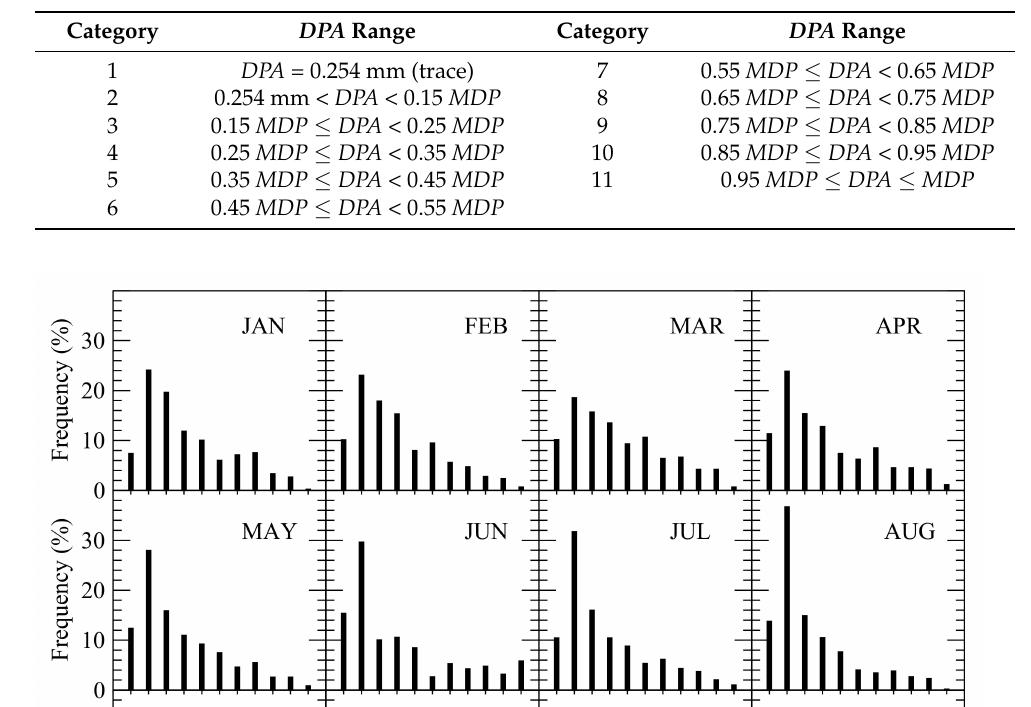
Table 6. Eleven categories of daily precipitation amount ( DPA ).